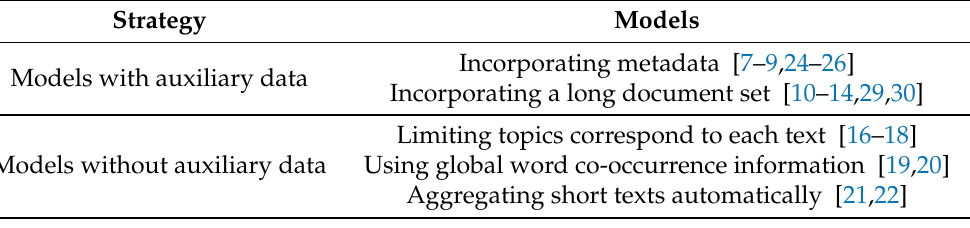
Table 1. Classification of topic models for short